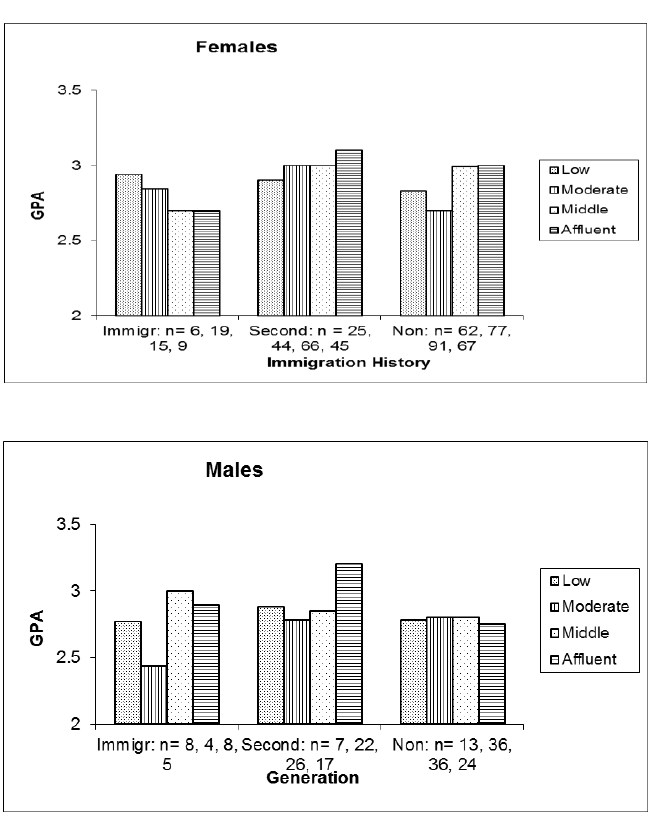
Figure 1 . GPA by immigration history, parent income, and sex of